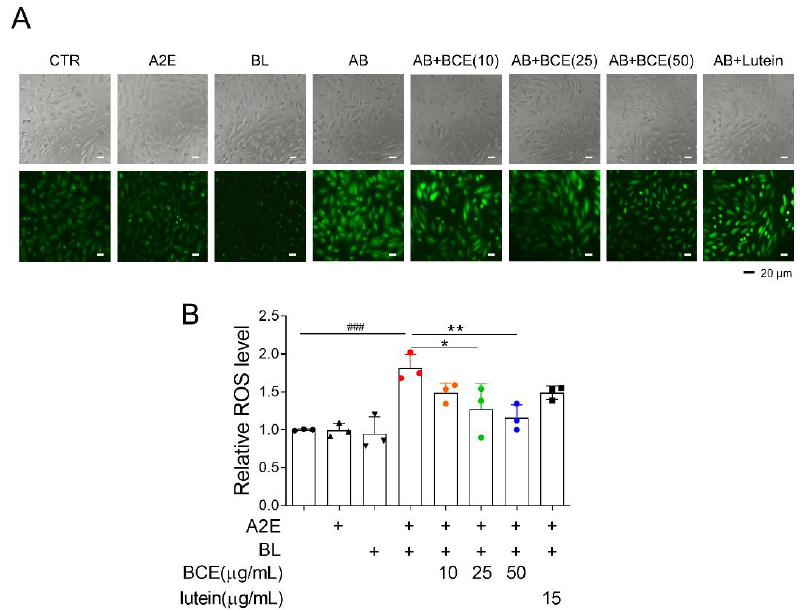
Figure 2. Antioxidant effects of BCE against the in vitro RPE damage model. ( A , B ) ARPE-19 cells were treated with A2E three times at 48 h intervals, and 24 h after the last treatment, BCE (10–50 µ g/mL) or lutein (15 µ g/mL) was treated twice at 24 h intervals. After 30 min of BL irradiation, the cells were recovered for 24 h. Cells were treated with DCF-DA (10 µ M) for 10 min in serum-free medium. After washing with 1 × PBS twice, the cells were monitored using JuLI™ smart fluorescent cell analyzer. The relative ROS level was quantified using Image J. The results are presented as the mean ± standard deviation of three independent experiments ( n = 3). ### p < 0.01 vs. normal group, * p < 0.05, ** p < 0.01 vs. A2E + BL.